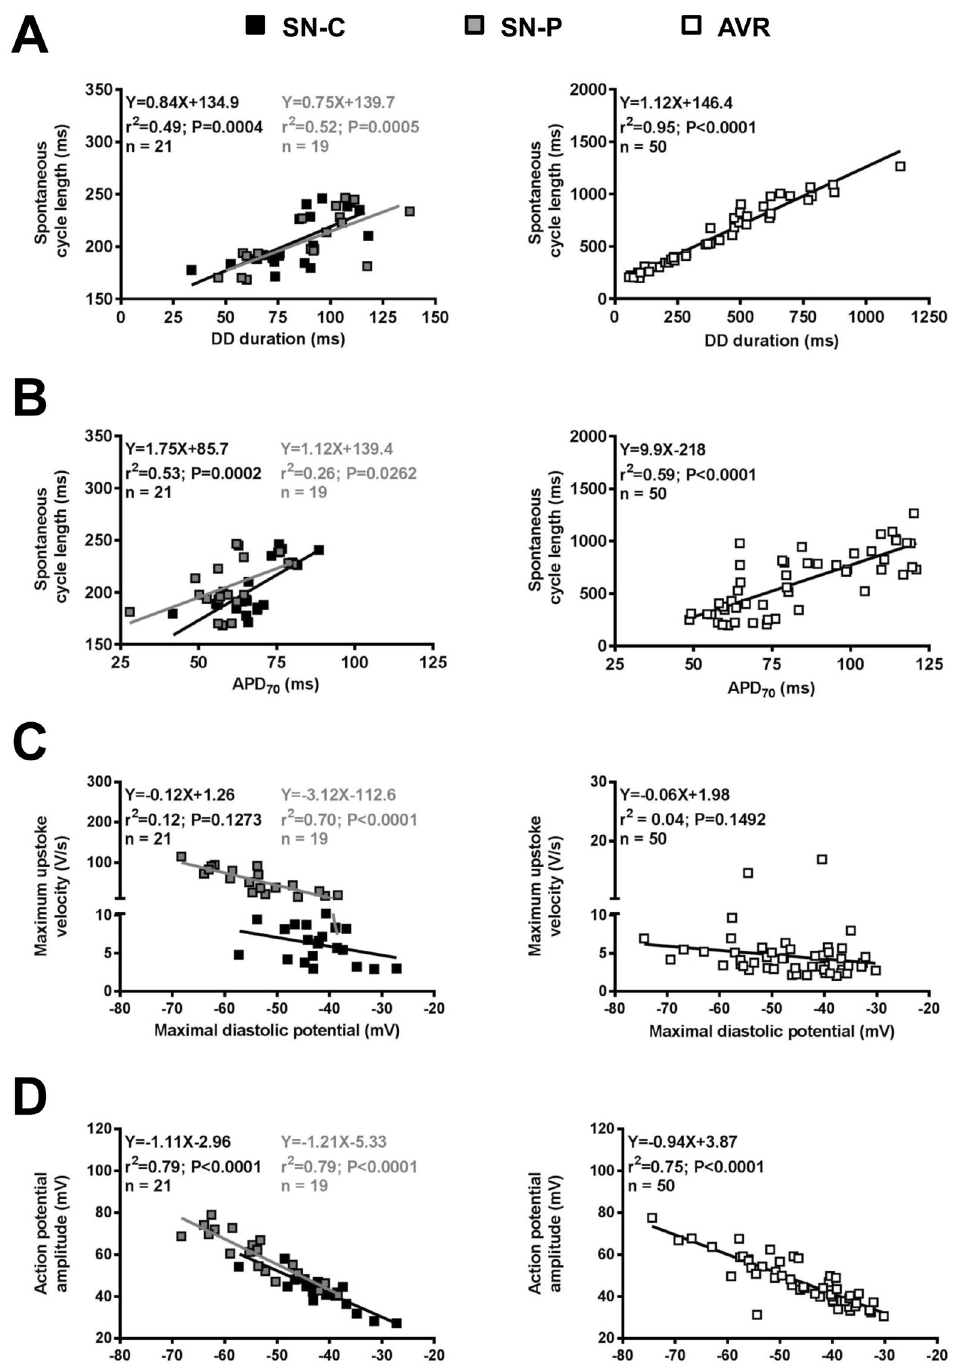
Figure 3. Correlation between pacemaker action potential parameter measurements. ( A – D ) correlation plots for sinus node-centre and -periphery (SN-C and SN-P; left plots) and atrioventricular ring (AVR; right plots). Measurements are from 21 SN-C (black squares), 19 SN-P (grey squares) and 50 AVR (white squares) myocytes. Best-fit trend lines were fitted by linear regression and results are shown in